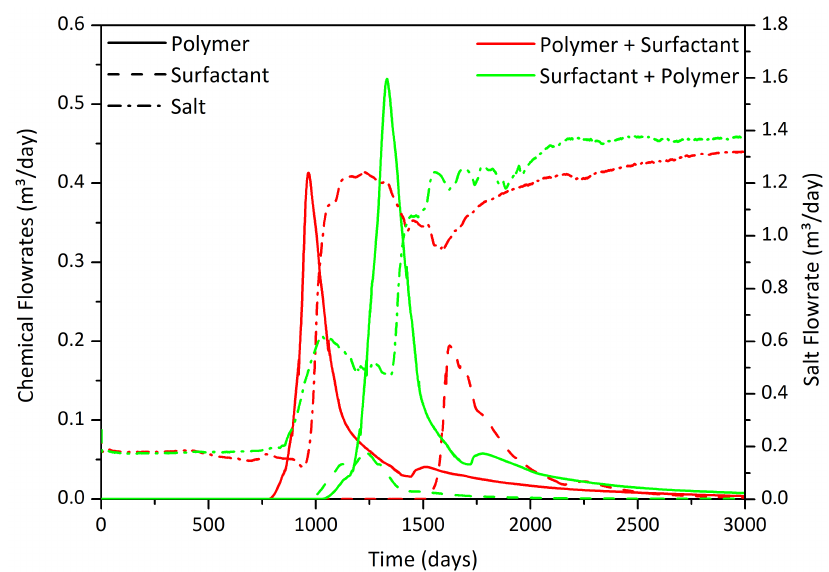
Figure 11. Chemical and salt flowrates as a function of time for the different SP injection schemes considering the adsorption process in a five pseudo-component system. The red lines represent the flow rates for an injection scheme ’Polymer + Surfactant’, while the green ones depict the behavior of the system for an injection scheme ’Surfactant + Polymer’. The line-types shown in the top left of the graph are used to differentiate the different components under